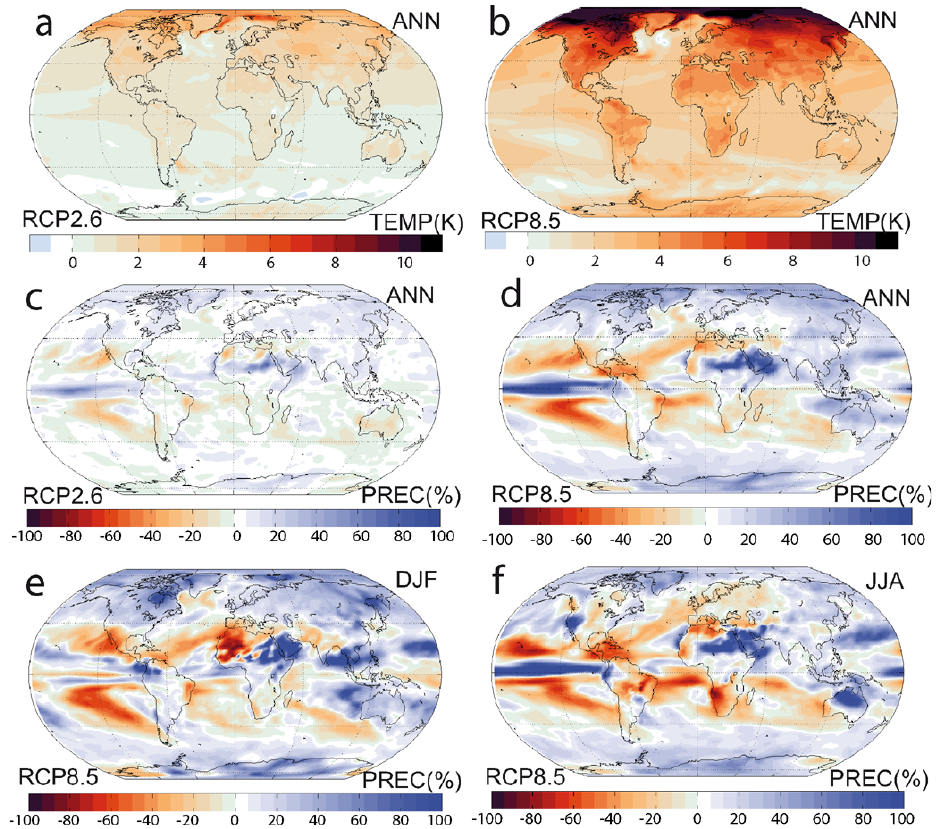
Fig. 8. Model simulated change in mean surface air temperature (K) (a, b) and percentage change in precipitation (c, d, e, f) from 1976–2005 to 2071–2100. Annual averages for RCP2.6 ( a and c ) and for RCP8.5 ( b and d ); RCP8.5 precipitation for (e) Dec-Jan-Feb and (f) Jun-Jul-